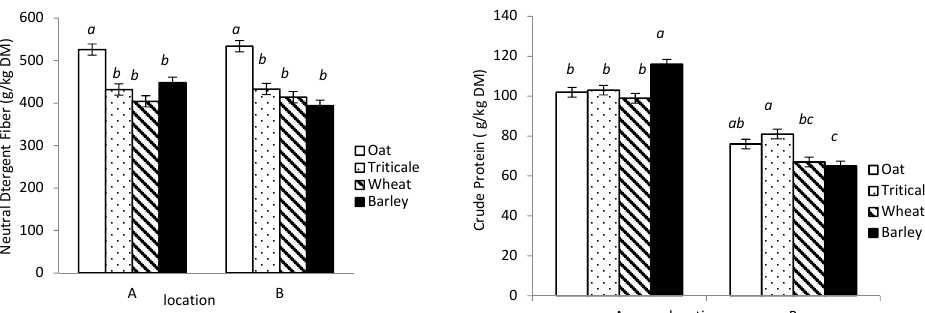
Figure 1. Whole-plant dry matter ( upper left ); starch ( upper right ); neutral detergent fiber ( lower left ); and crude protein ( lower right ) concentrations of oat, triticale, wheat, and barley whole plants grown and harvested at two locations in central Alberta (A = Agriculture and Agri-Food Canada; B = Alberta Agriculture). Means without a common letter differ at p < 0.05 (a–c) within the different locations.